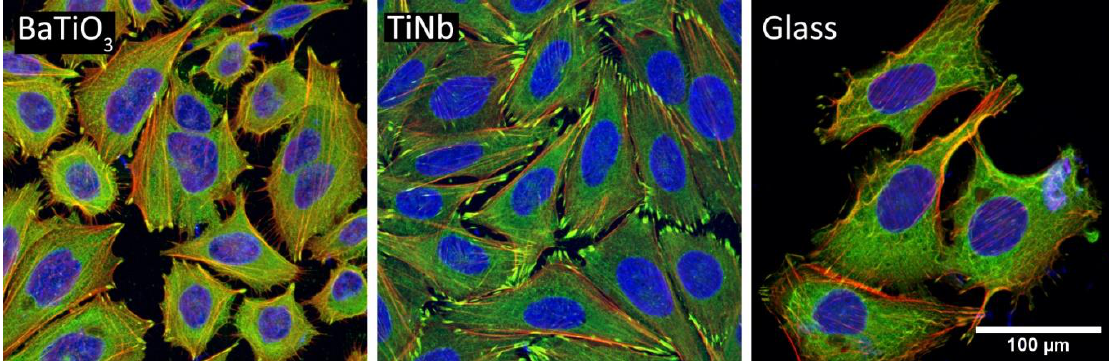
Figure 11. Immunofluorescence staining of vinculin ( green ), F-actin cytoskeleton ( red ), and nuclei ( blue ) in osteoblast-like Saos-2 cells on day 3 after seeding on Ti39Nb alloy coated with BaTiO 3 (BaTiO 3 ), bare Ti39Nb alloy (TiNb), and control microscopic glass coverslip (Glass). Bar = 100 µm.